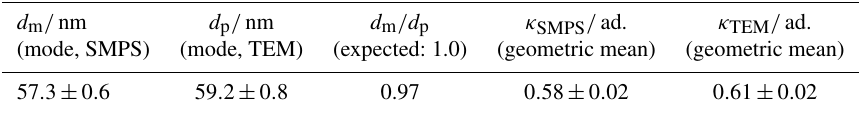
Table 1. Parameters of the lognormal distributions used in the activation experiments of ammonium sulfate particles and shown in Fig. 3. The uncertainties are calculated from the lognormal fit of the distributions. The table also shows the comparison of κ SMPS and κ TEM . d m / nm d p / nm d m /d p κ SMPS / ad. κ TEM / ad. (mode,